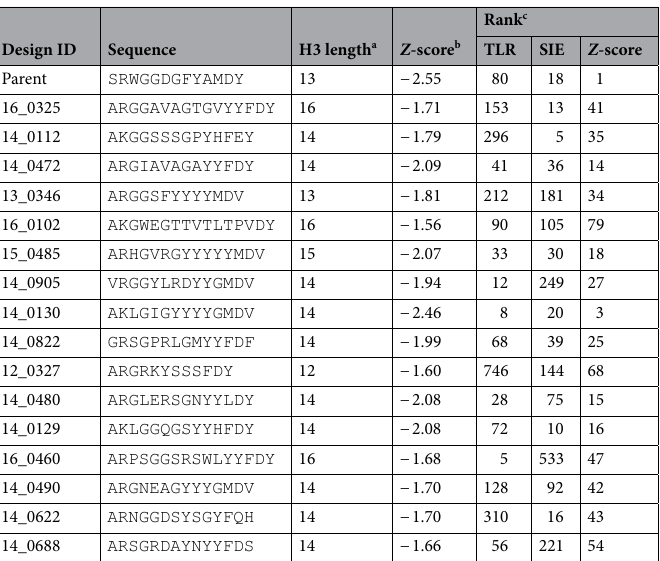
Table 1. Selected H3 sequences for experimental validations. a Loop sequence length, in amino-acid residues, according to the IGMT definition 46 . b Z -scores are calculated for the given loop length. c Ranks for the TLR (Rosetta Talaris) and SIE scores are across the entire library. The Z -score value is calculated using a median for a given length. Z -scores for all designs are then merged and a rank